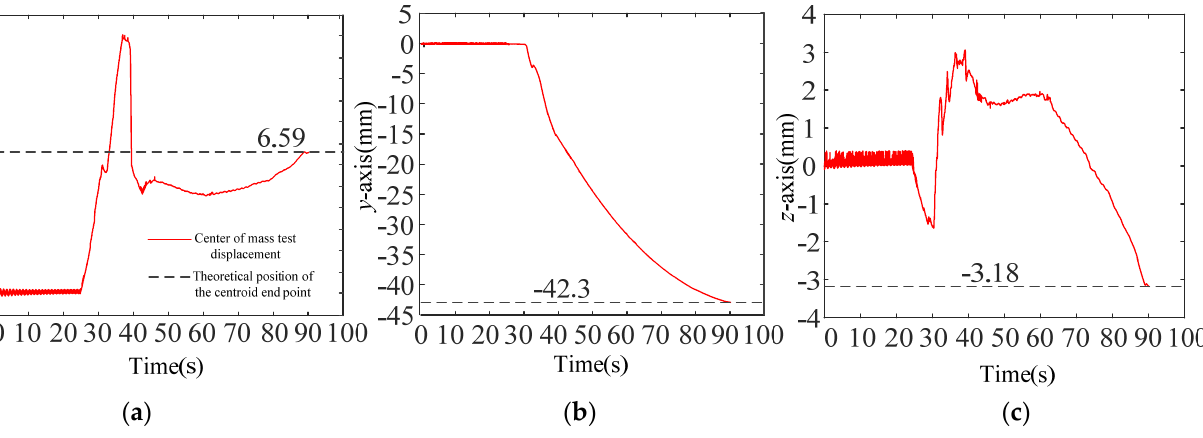
Figure 29. The displacement of the center of mass of the captured test payload in the second boundary pose (see Table 5 for details). ( a ) The x -axis displacement of the center of mass of the captured test payload in the second boundary pose; ( b ) The y -axis displacement of the center of mass of the captured test payload in the second boundary pose; ( c ) The z -axis displacement of the center of mass of the captured test payload in the second boundary pose.